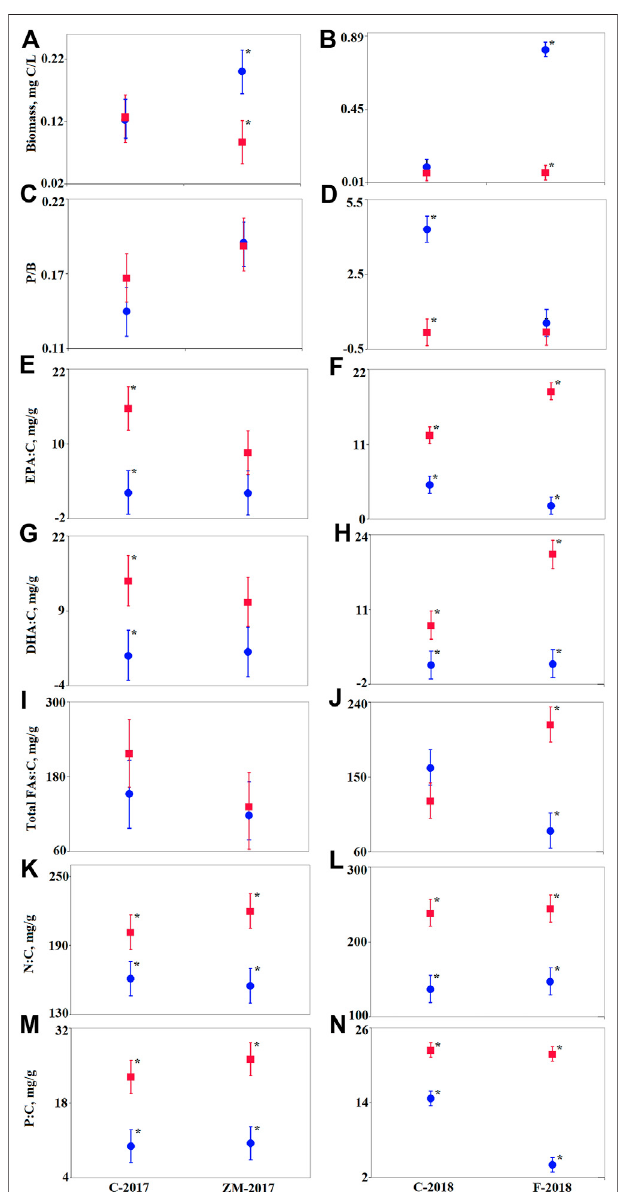
FIGURE 4 | Comparison of biomass (A, B) , P/B ratio (C, D) , and mean contents of the main substances (E – N) on day 30 in experimental treatments [C-2017 and ZM-2017 (left column) , and C-2018 and F-2018 (right column) ] between phytoplankton (blue circles) and zooplankton (red squares). See Tables 2 , 3 for statistical parameters obtained by two-way GLM ANOVA. The factors were treatment and trophic level (zooplankton and phytoplankton) and their interaction. Data are presented as means with 95% Fisher ’ s LSD intervals using the post hoc test. Signi fi cant differences between phytoplankton and zooplankton parameters are designated by